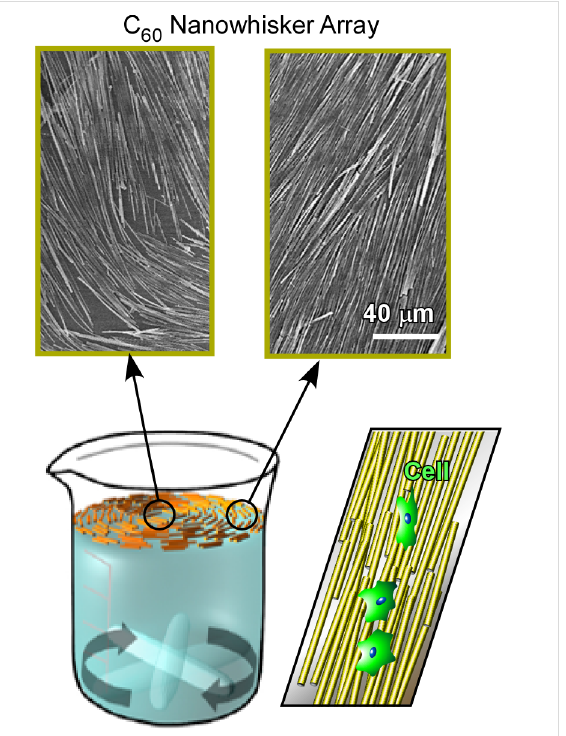
Figure 27: One-dimensional C 60 nanowhiskers with controlled align- ment and curvature fabricated by a vortex LB method for the culture of bone-forming human osteoblast MG63